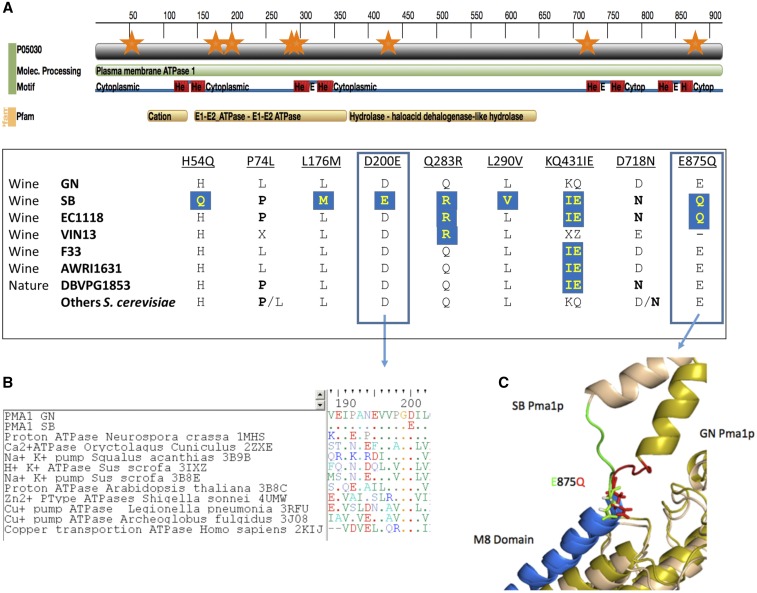
(A) ns-SNPs found within GN and SB on the PMA1 gene. Each orange star represents one ns-SNP; the predicted cytoplasmic and transmembrane regions, as well as the domains, were obtain from the Pfam web site (European Molecular Biology Laboratory-European Bioinformatics Institute). A protein sequence alignment allows the detection of nine ns-SNPs that will be compared to the sequence of 97 S. cerevisiae strains (File S6). (B) The D200E variation found in strain SB was located in a very conserved region within 144 transmembrane transporters. (C) The E875Q allele (SB) impacts the orientation of the fifth transmembrane domain of the protein (3D model carried out with phyre2 tools). ATPase, adenosine triphosphatase; Cytop., cytoplasmic; Molec., molecular; ns-SNPs, nonsynonymous sequence polymorphisms.